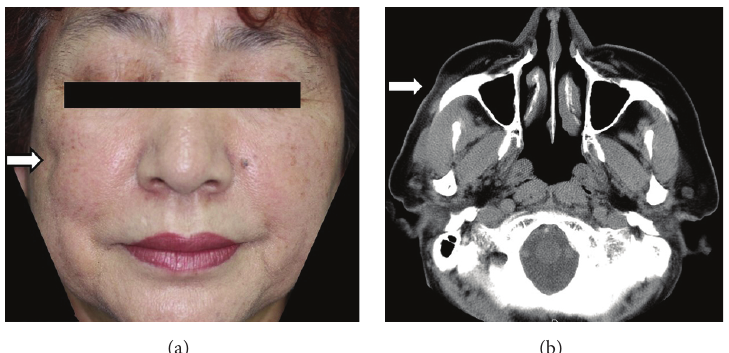
Figure 1: (a) Clinical manifestation at admission. (b) Axial computed tomography images, with soft-tissue settings, showing atrophy of subcutaneous fat on the right side of the